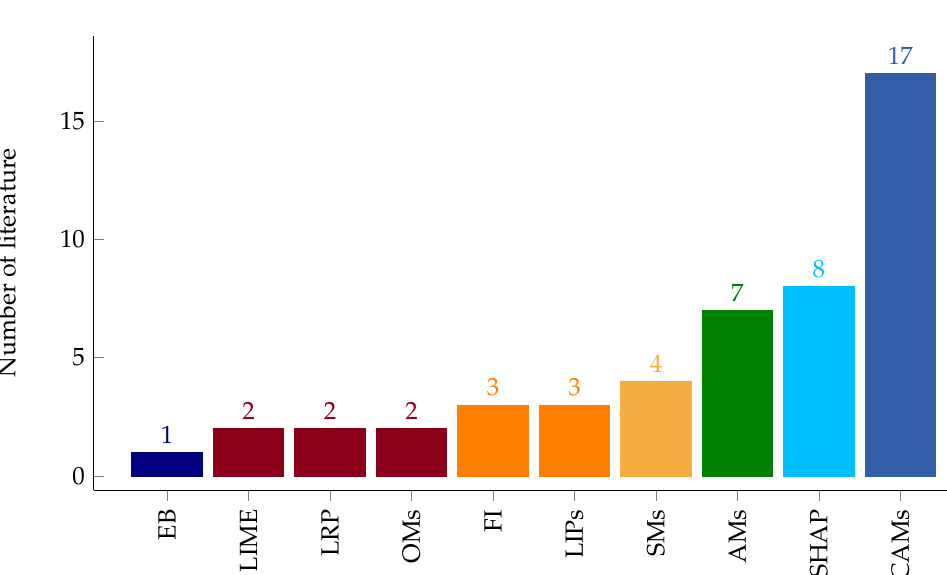
Figure 7. Yearly distribution of the reviewed research papers.